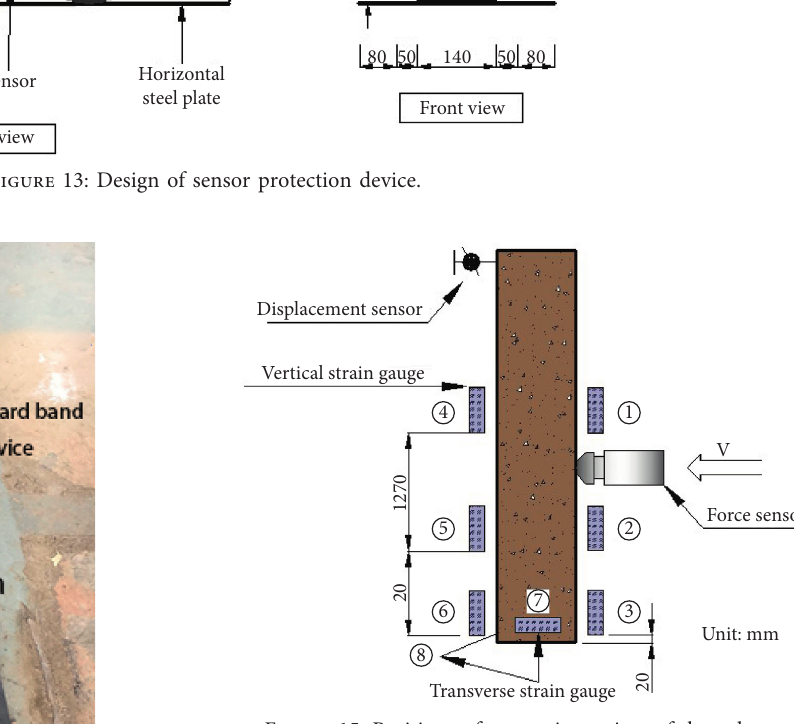
Impact Heights. Figure 19 reflects the variation of the dis- placement of the column top under different falling heights of the swing ball. S ∼ S reached the maximum pier top 8.3-1 8.3-4 displacement in the direction of impact within 2 ms after 4.6 mm, 8.6 mm, 17 mm, and 48.5 mm. The relation between